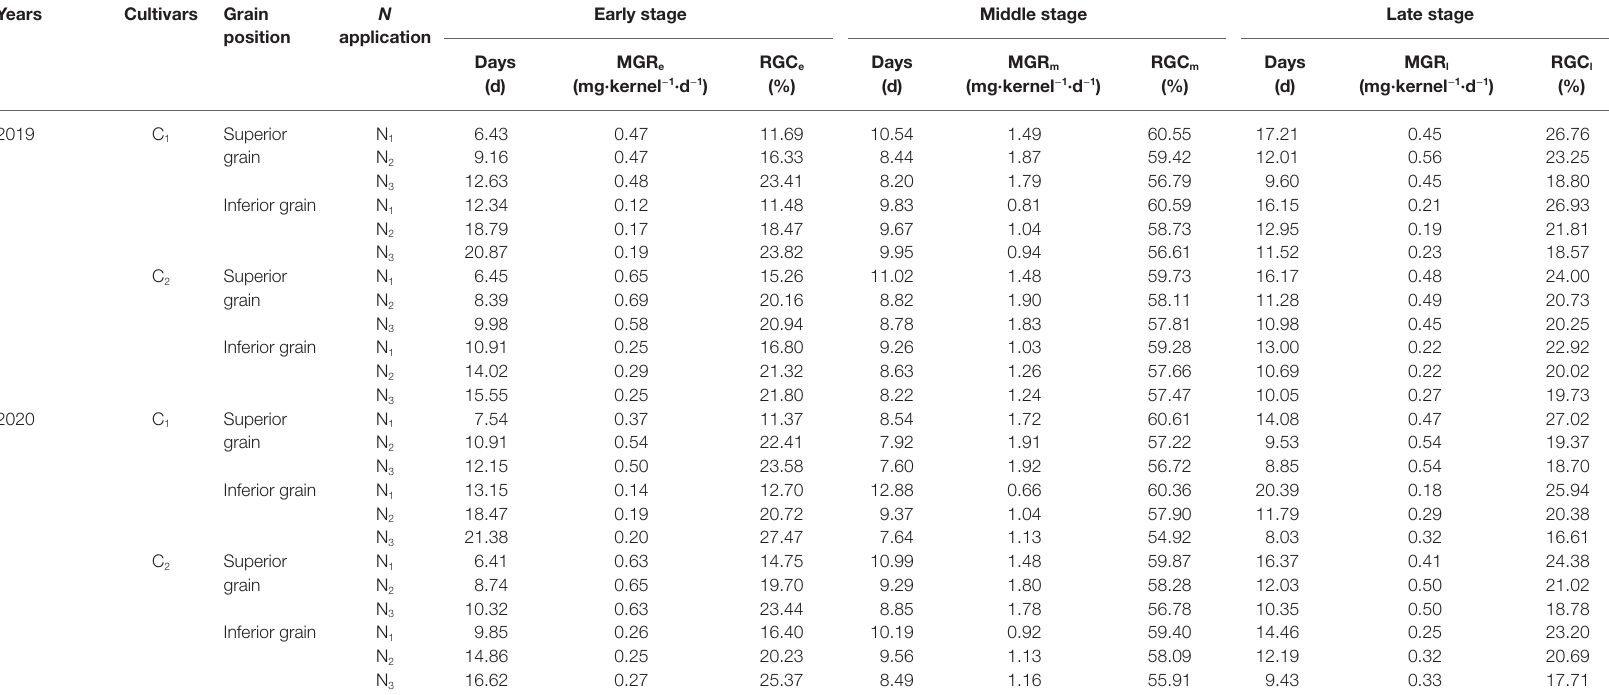
TABLE 3 | Effects of nitrogen application rate on grain filling characteristics in early, middle, and late